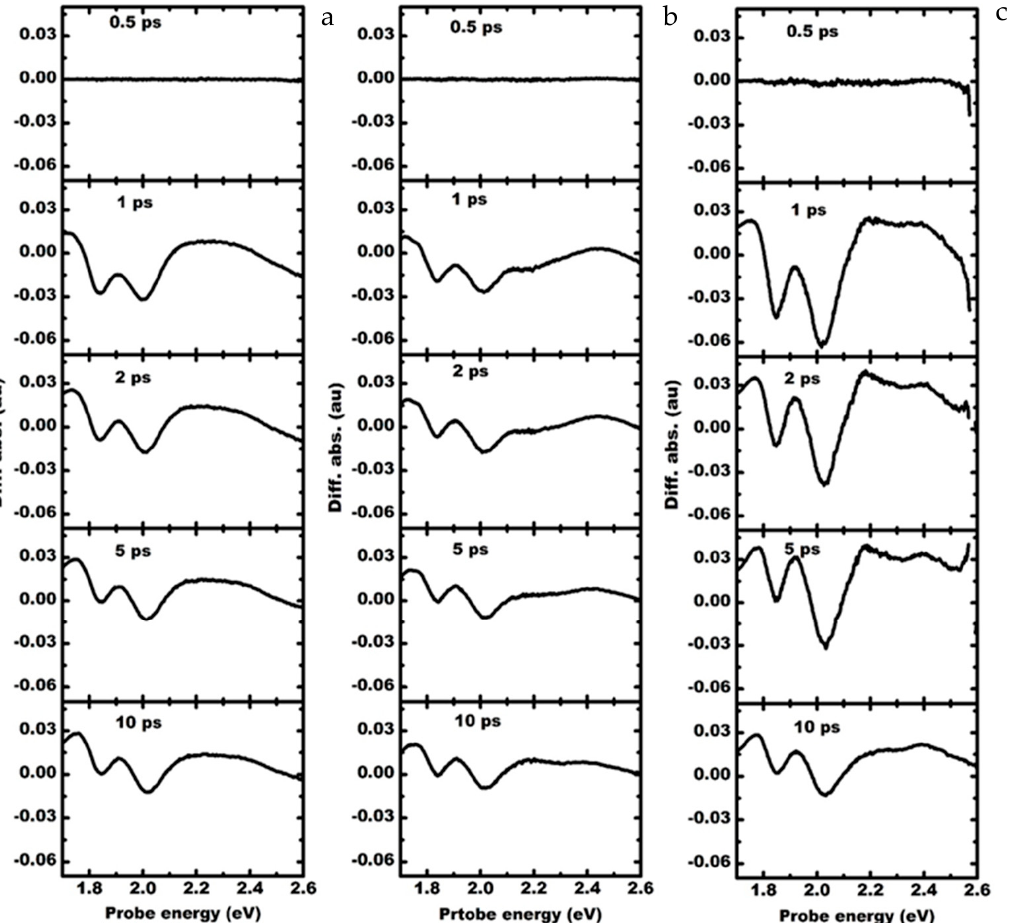
Figure 6. Transient absorption spectrum of ( a ) MoS 2 -GaN (left column), ( b ) MoS 2 -GaN with Au plasmons (middle column) and ( c ) MoS 2 -GaN with Pt plasmons (right column) 3.06 eV pump excitation.